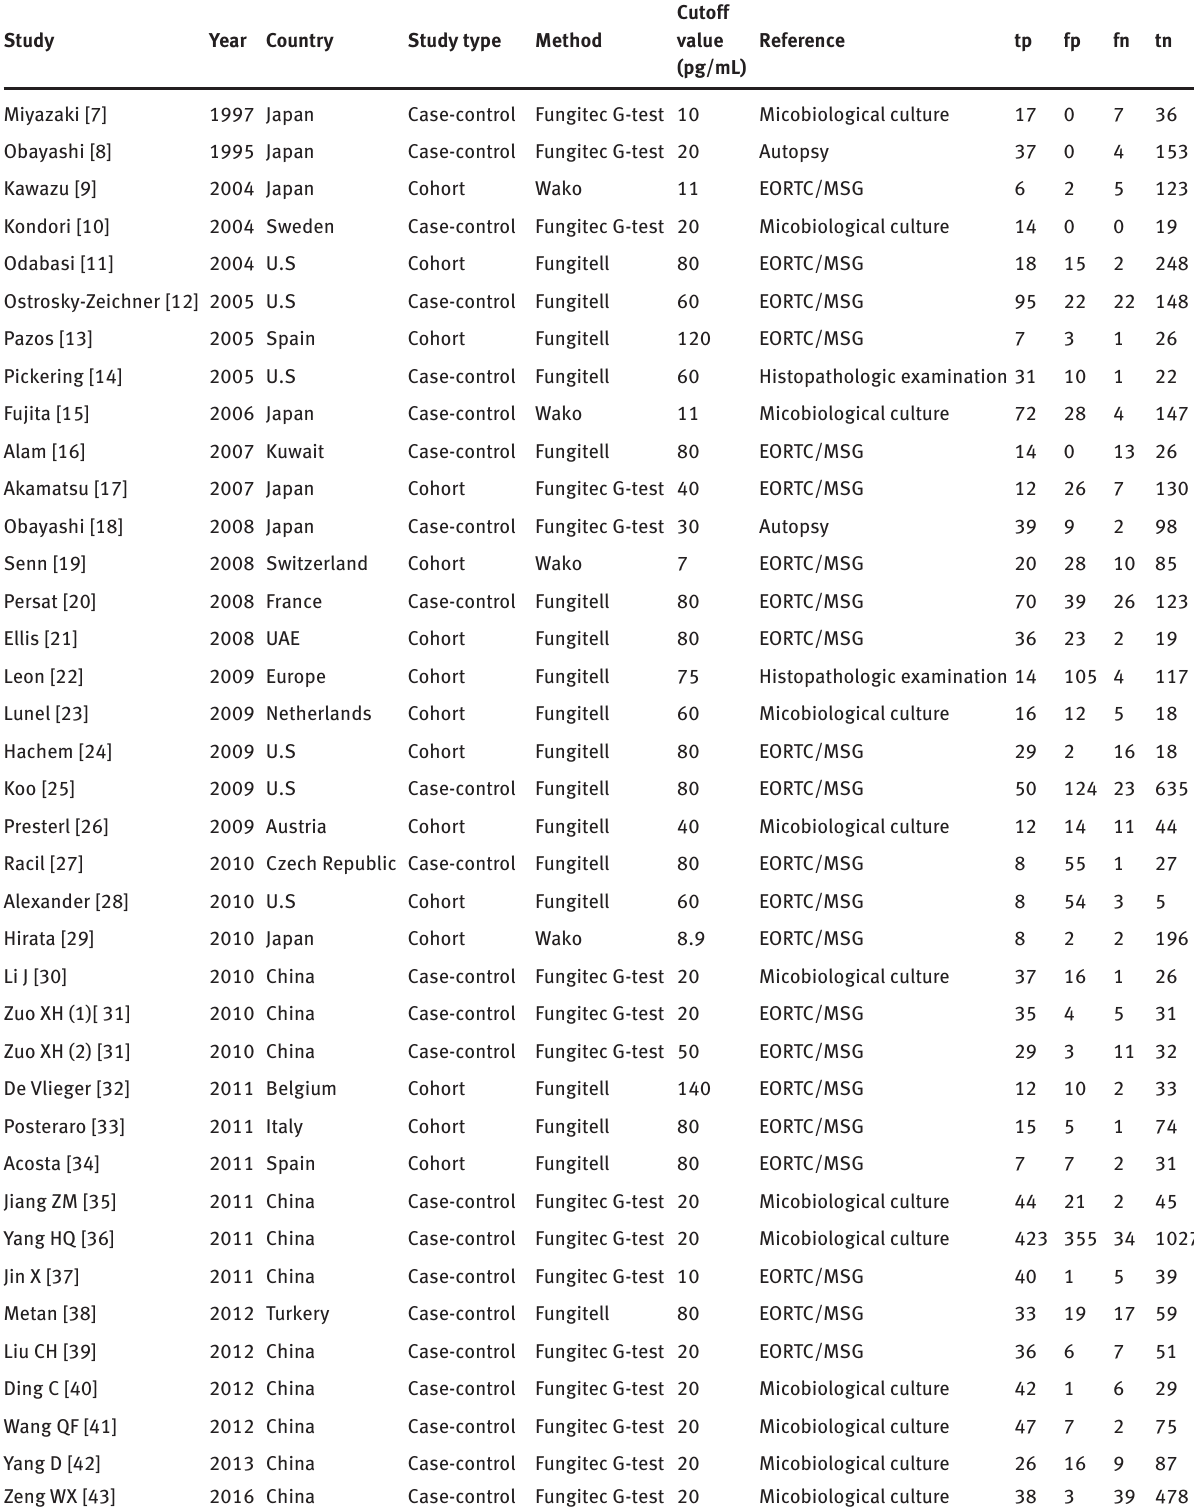
Table 1: The main characters of the recruited 37 publications